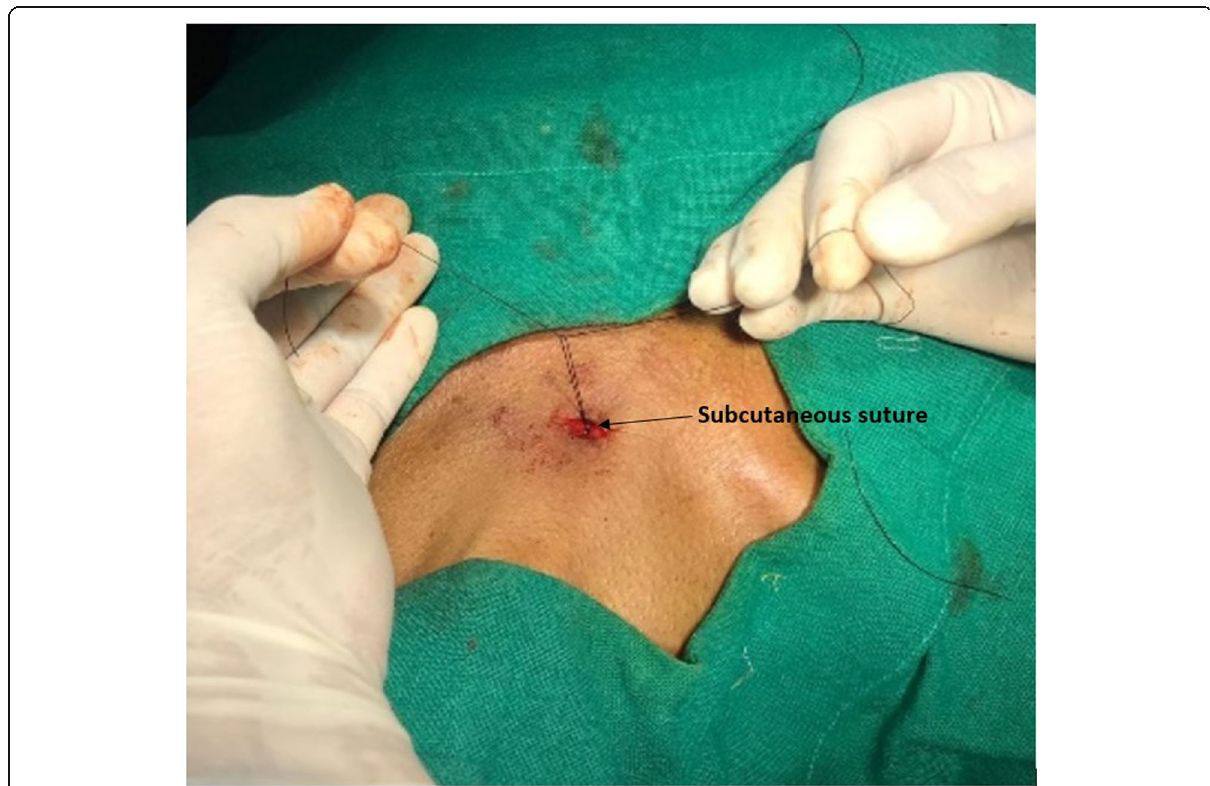
Fig. 5 Image of suture knot at subcutaneous